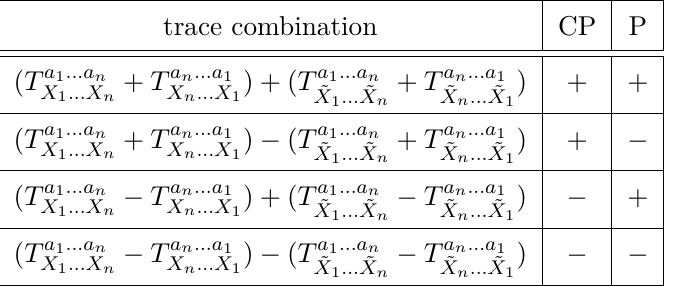
Table 4 . Combinations of single traces eigenstates of CP and